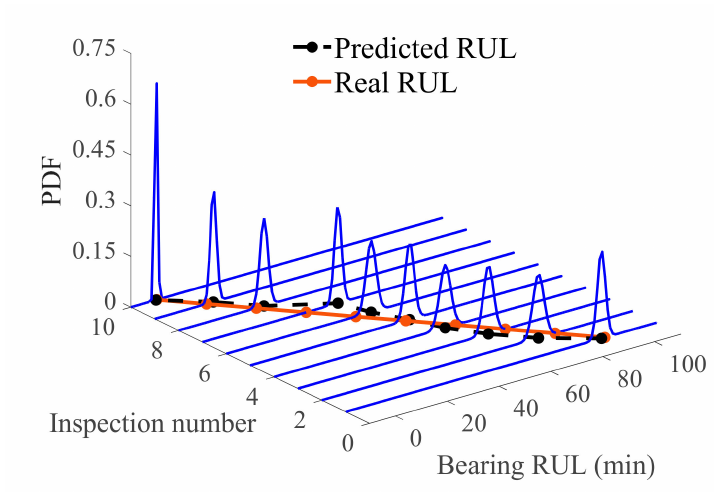
Figure 7. Probability density diagram of bearing RUL.